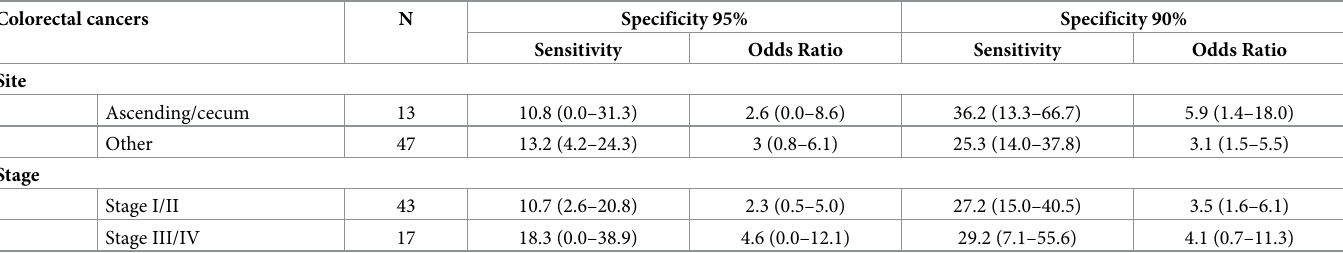
Table 4. Sensitivity and odds ratio of colonflag for different categories of colorectal cancer in all study patients. Colorectal